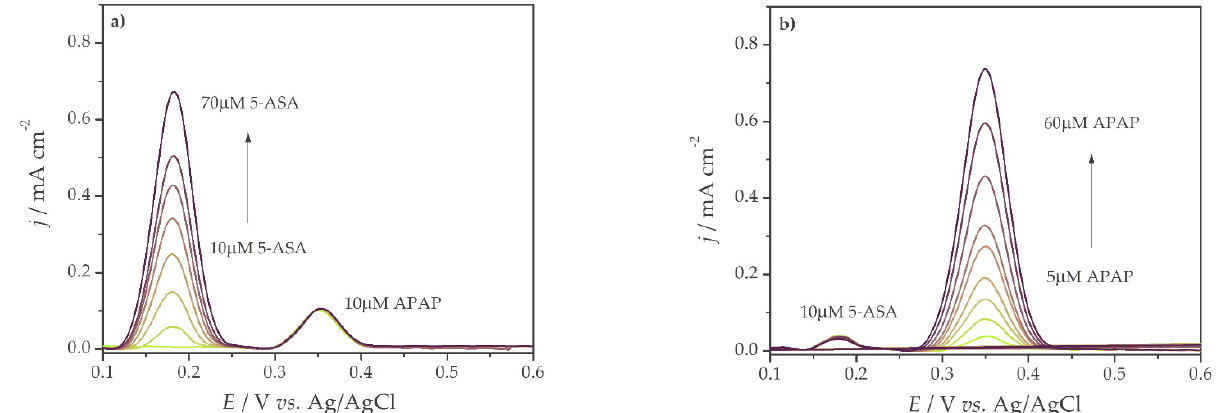
Figure 6. DPVs ( v = 4 mV s − 1 , step potential 2 mV, pulse amplitude 50 mV) with CNT/PMB DES /GCE in 0.04 M BR pH 7.0 for a solution containing 5-ASA and acetaminophen (APAP) in different ratios. ( a ) 10.0, 20.0, 30.0, 40.0, 50.0, 60.0, and 70.0 µ M 5-ASA in the presence of 10.0 µ M APAP; ( b ) 5.0, 10.0, 15.0, 20.0, 30.0, 40.0, 50.0, and 60.0 µ M APAP in the presence of 10.0 µ M 5-ASA.